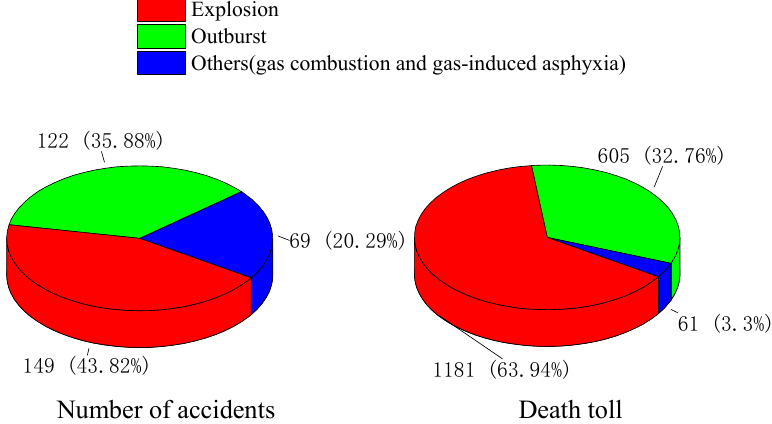
Figure 9. Proportion of various types of accidents in tremendous and above gas accidents from 2008 to 2018.